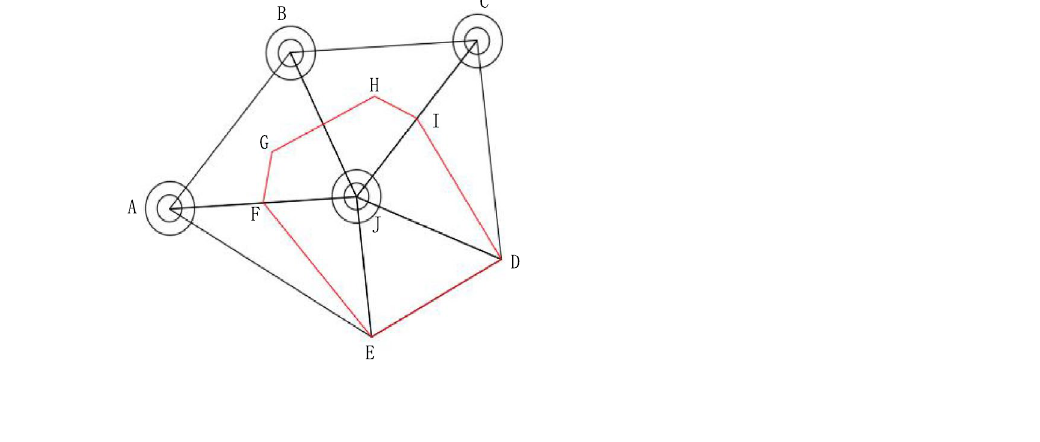
Figure 2. blast hole influence